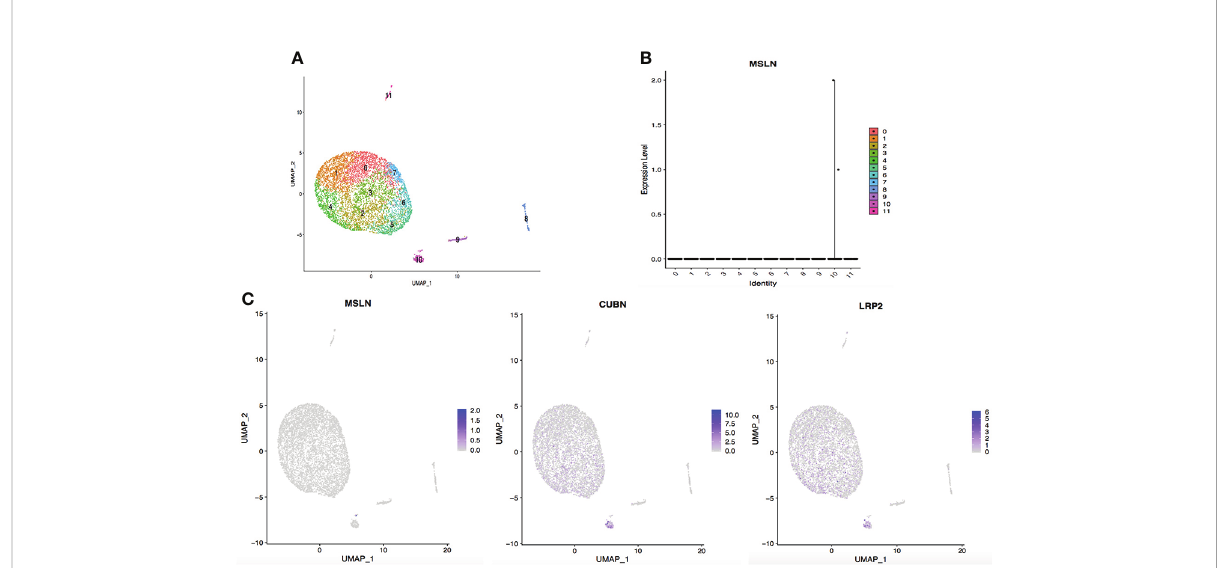
FIGURE 7 Analysis of scRNA-seq data showing low expression of MSLN in the kidney. (A) Cells in the kidney were categorized into 12 different clusters, numbered 0 to 11. (B) Violin plot of MSLN expression distribution in these 12 different cell clusters. (C) Scatter plots showing that the cluster of cells with MSLN expression also expressed the typical renal cells markers CUBN and LRP2.